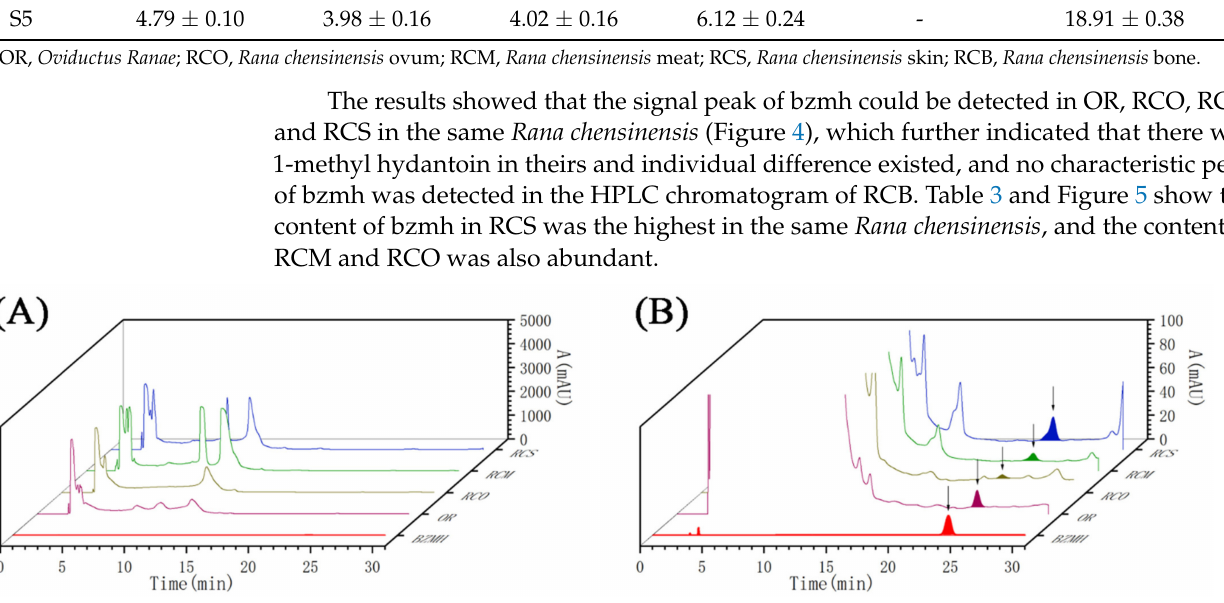
Figure 4. The HPLC chromatogram of bzmh standard, OR, RCO, RCM, RCS, and RCB. ( A ) A: 0–5000 mAU; ( B ) A: 0–100